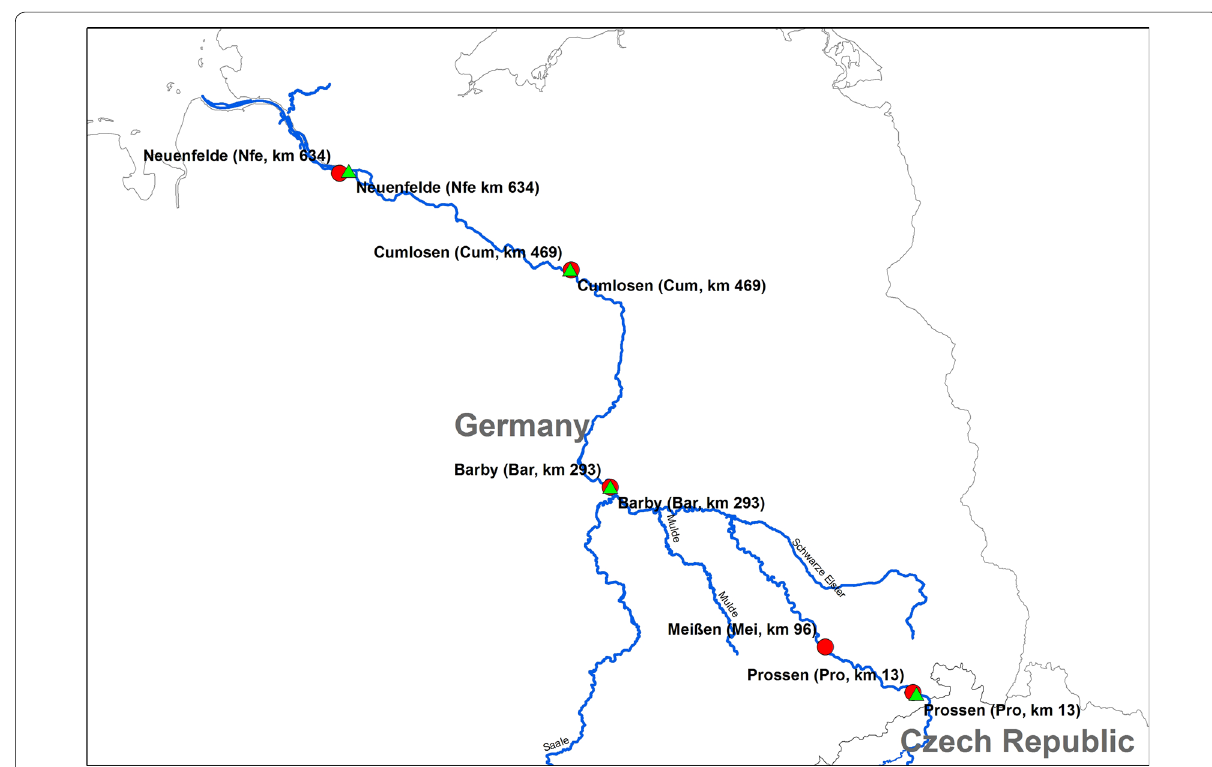
Fig. 1 Sampling stations along the Elbe River. Sediment (red dots) and SPM (green triangles) samples were collected at Neuenfelde (Nfe, 634 river km), Cumlosen Barby (Bar, 293 river km), Meißen (Mei, 96 river km) and Prossen (Pro, 13 river